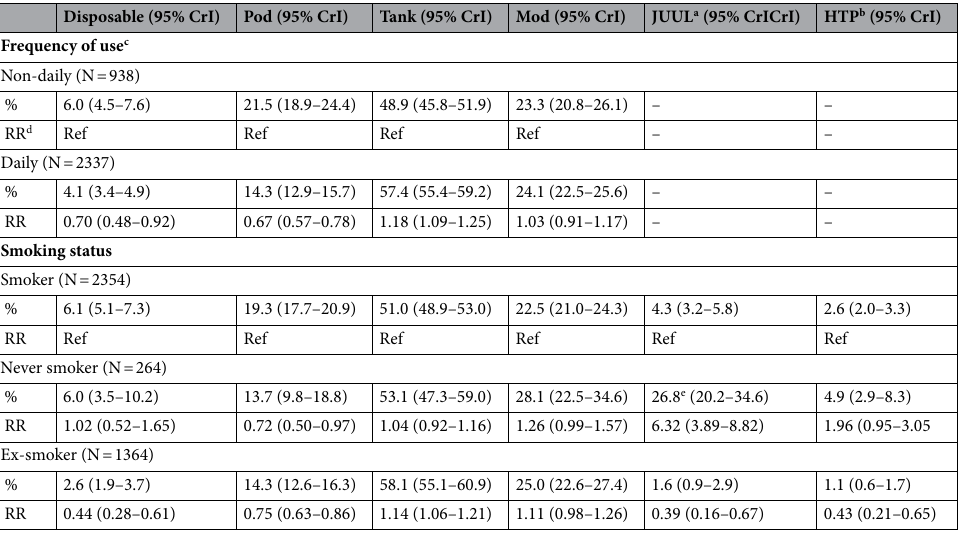
Table 2. Device type use by frequency of use and smoking status among people who reported using HANDS. Heated aerosolized nicotine delivery systems (HANDS) include e-cigarettes and heated tobacco products. Percentages are unweighted. a Use of JUUL was recorded from July 2018 ( n = 1760). Frequency could not be assessed as all JUUL users had used combinations of products. b Use of heated tobacco products (HTPs) was recorded from December 2016 ( n = 3520). Frequency could not be assessed as all but one HTP user used combinations of products. c Participants who used combinations of products or NRT were excluded. d RR represent risk ratio. e The high prevalence of JUUL use among never smoking HANDS users was primarily driven by data from a single month in a specific local authority area. Therefore, it likely represents a localised effect.